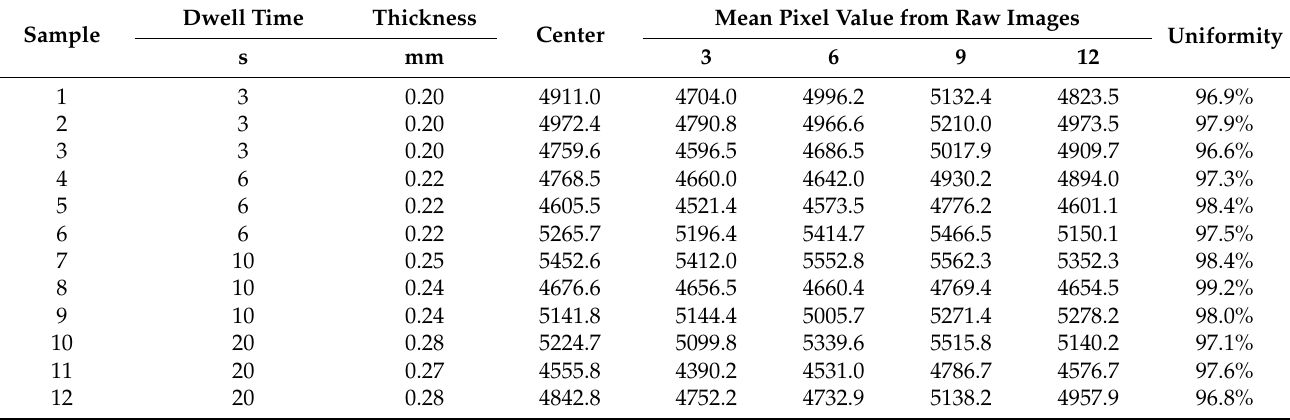
Table 8. RA uniformity of films made with 150 PHR Bi 2 O 3 loading and thickness ranging from 0.20 mm to 0.28 mm. Regions of interest (100 × 100 pixels) were created in the center and at each clock position of 3, 6, 9, and 12 of the